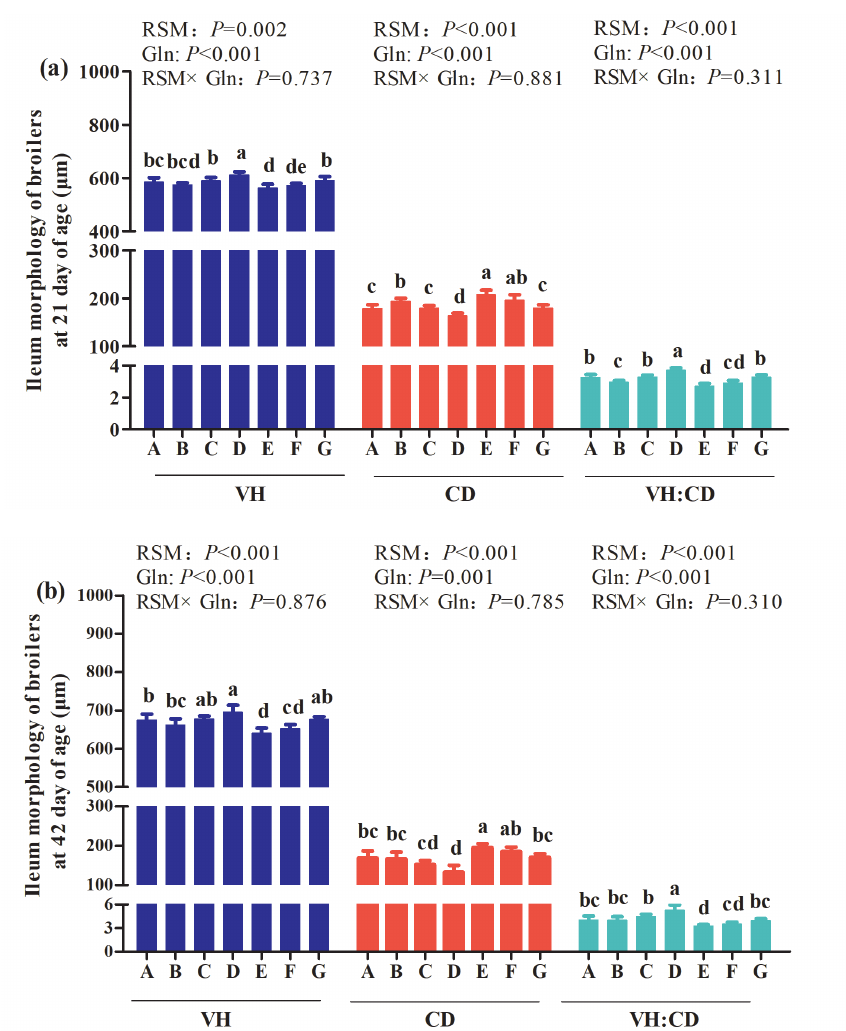
Figure 2. Effects of different levels of rapeseed meal substitution and glutamine on ileum morphology of Qiandongnan Xiaoxiang Chicken at 21 and 42 days of age (n = 10 per treatment group). Columns in the same color with different small letters superscripts mean significant differences (p<0.05). Broilers in the control group (A) were fed with basal diet. Broilers in 10% (B) and 20% RSM (E) were fed with diet containing 10% or 20% RSM, respectively. 10% RSM+0.5% Gln (C), 10% RSM+1.0% Gln (D), 20% RSM+0.5% Gln (F), and 20% RSM+1.0% Gln (G) mean that 0.5% Gln or 1% Gln was separately supplemented based on 10% and 20% RSM